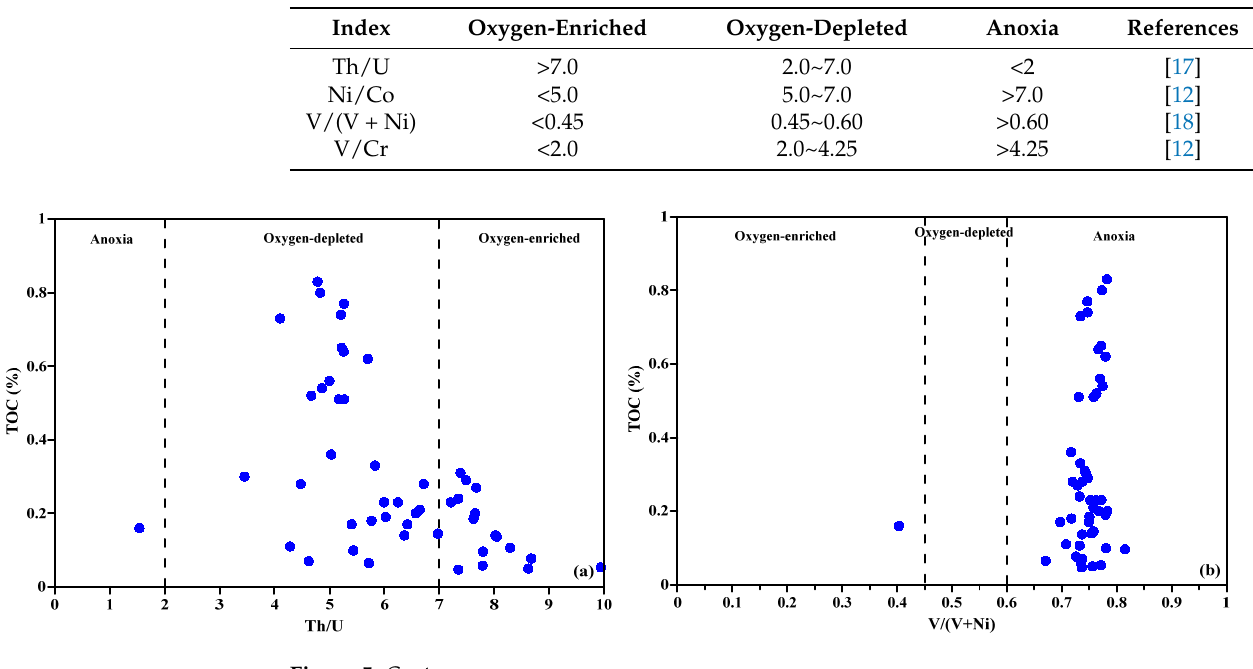
Table 4. Paleoredox evaluation index.